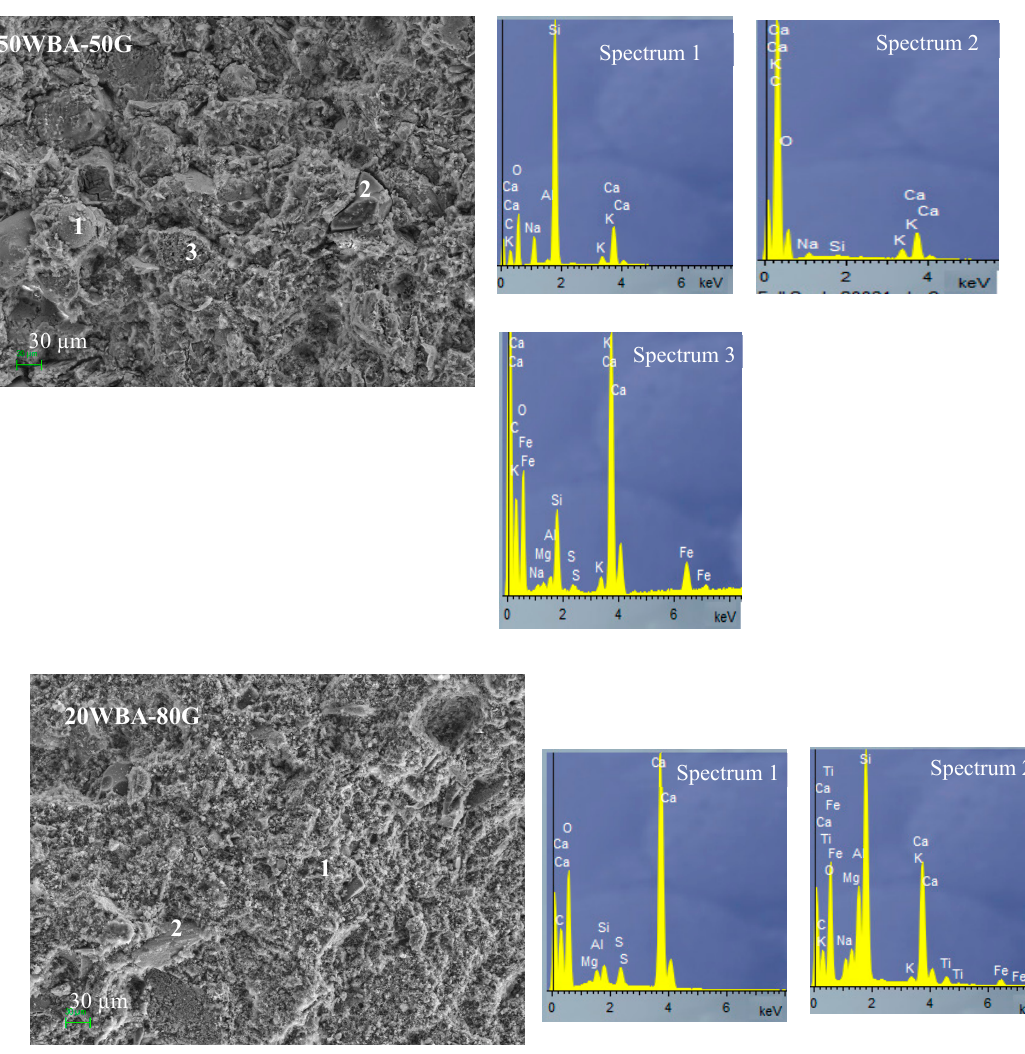
Figure 12. SEM ‐ EDS analysis of 90WBA ‐ 10G, 50WBA ‐ 50G and 20WBA ‐ 80G calcium silicate units. Figure 12. SEM-EDS analysis of 90WBA-10G, 50WBA-50G and 20WBA-80G calcium silicate